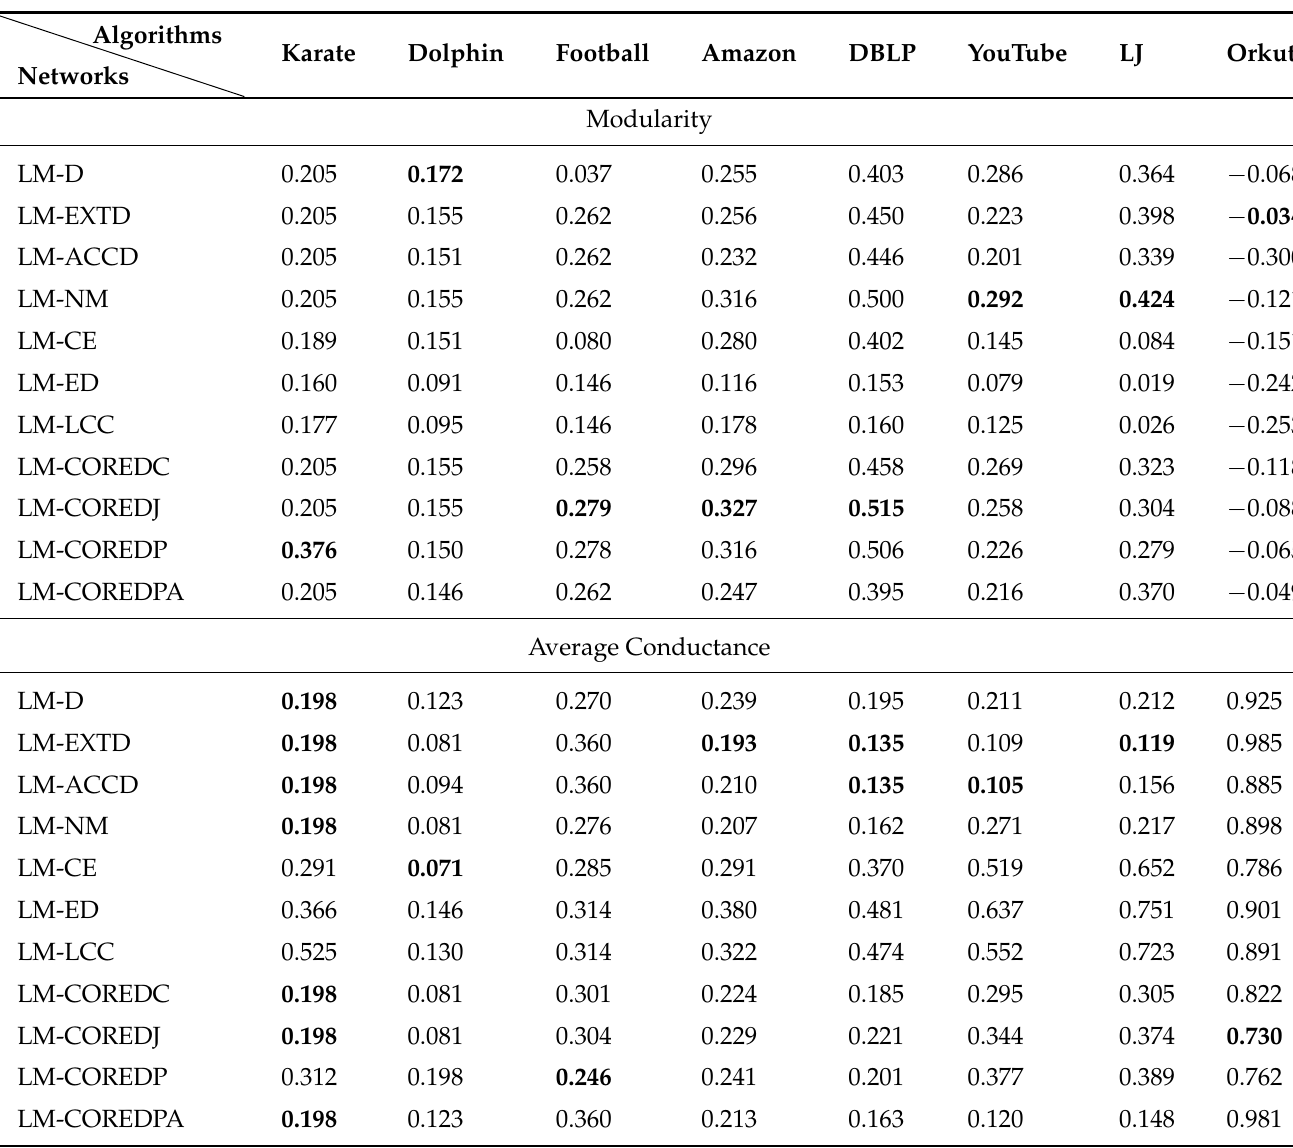
Table 7. The modularity and average conductance of communities resulting from different local seeding